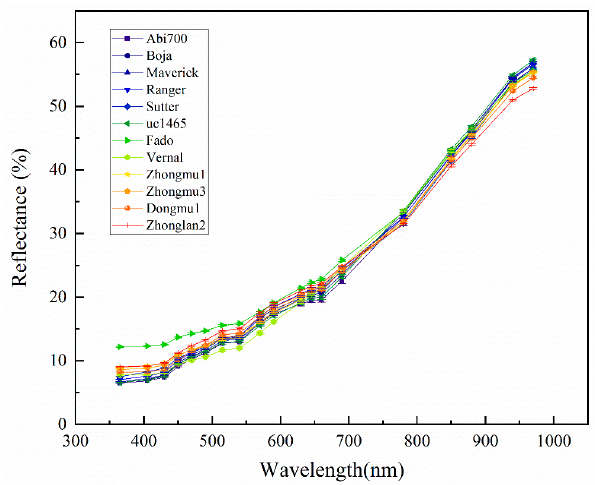
Figure 3. Mean light reflectance of 19 wavelengths (nm) in 12 Medicago sativa L. cultivars.